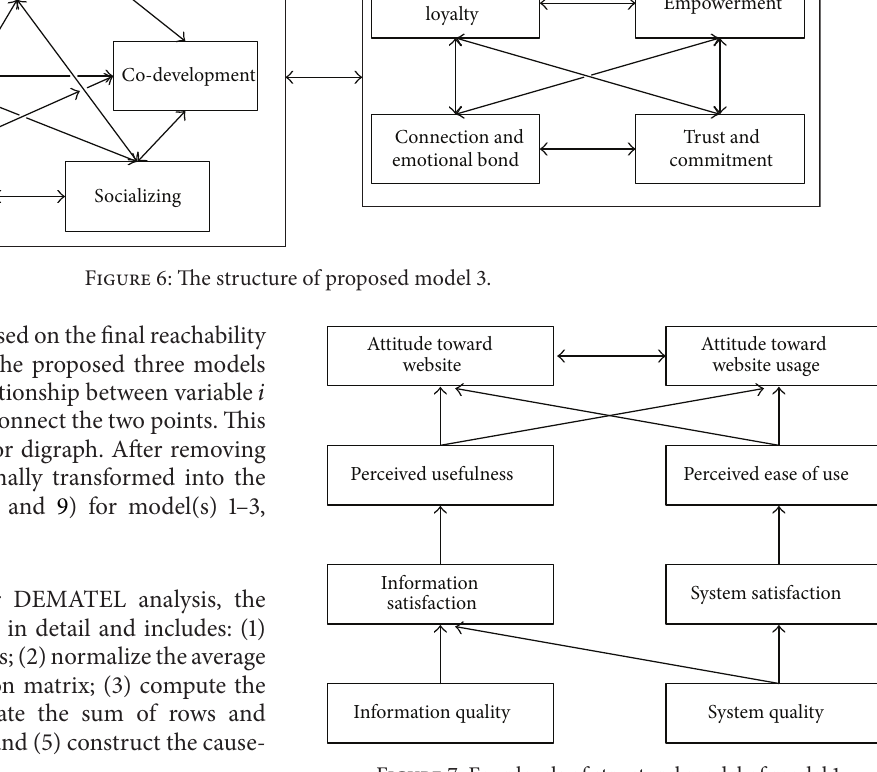
Figure 7: Four levels of structural model of model